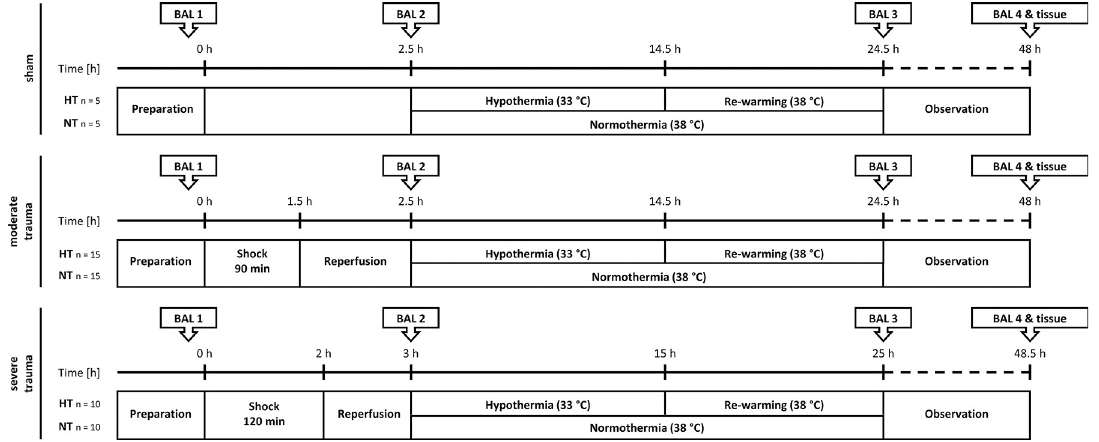
Fig 2. Experimental groups. Animals underwent preparation and standardized trauma induction (including blunt chest trauma, liver laceration, and tibial fracture). Hemorrhagic shock was induced by blood volume removal until reaching a mean arterial pressure of 30 ± 5 mmHg over 90 min. in moderate and 25 ± 5 mmHg over 120 min. in severe trauma groups. Following resuscitation and reperfusion with warmed Ringer´s acetate solution, animals were randomized to either intervention with mild hypothermia and subsequent rewarming or normothermic observation. Sham animals were not injured. In the hypothermia groups, the body temperature was reduced to 33˚ C. After rewarming at 0.5˚ C per hour over 10 hours, animals were observed for additional 24 hours. Bronchoalveolar lavage (BAL) fluid was sampled before trauma induction (BAL1), after reperfusion (BAL2), after rewarming (BAL3), and at the end of the observational period (BAL4), respectively. Lung tissue samples were taken at the end of the observational